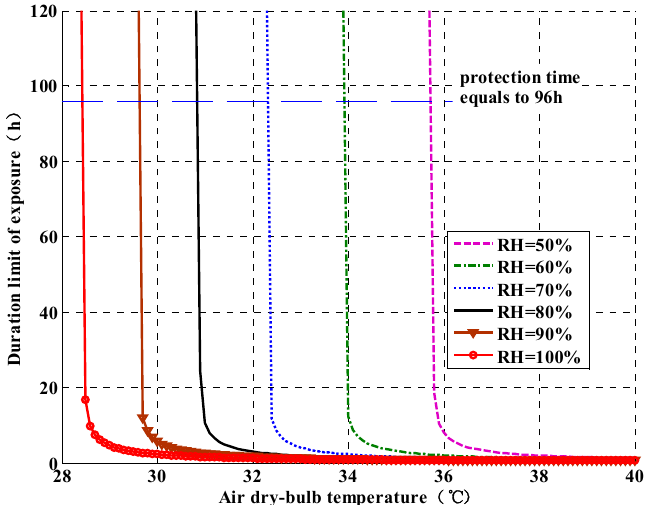
Figure 4. The relationship between the duration limit of exposure and the air temperature and humidity.